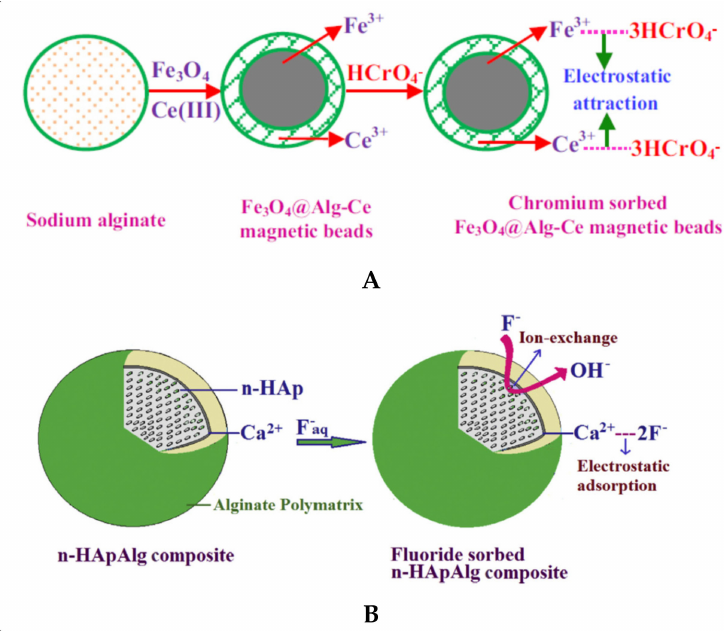
Figure 6. Structure of SA/magnetic ( A ) (reprinted with permission from ref. [67]) and SA/hydroxyapatite ( B ) composite beads (reprinted with permission from ref. [66]) and subsequent interaction with